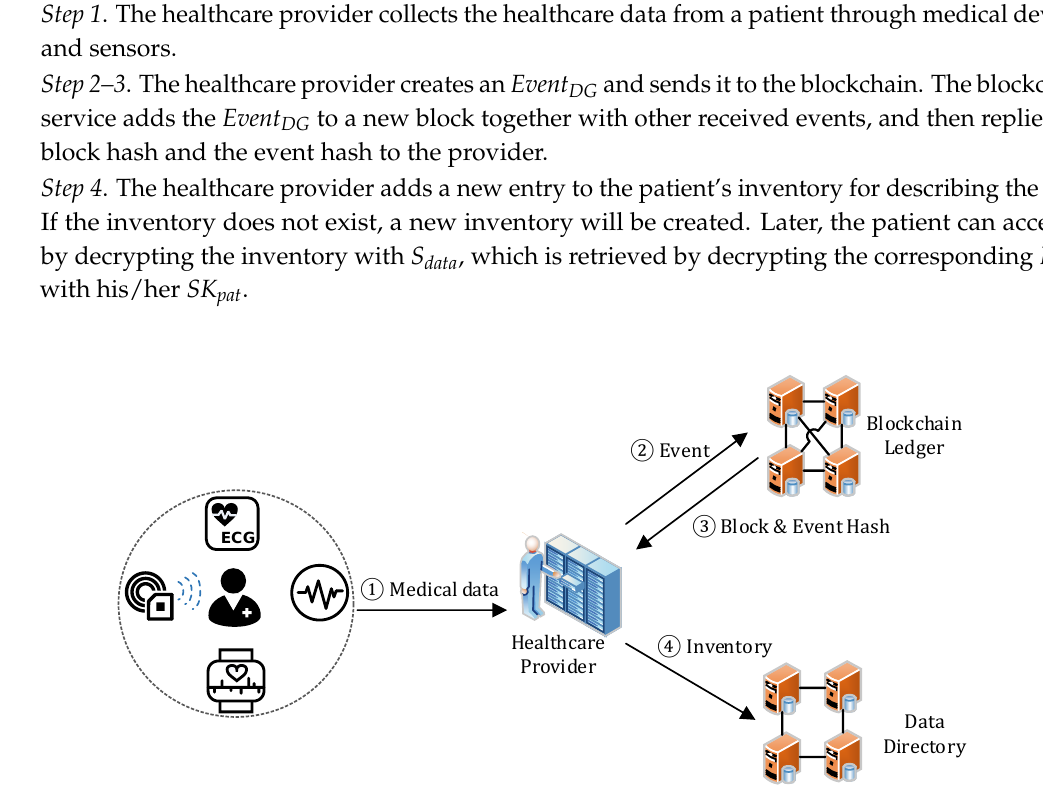
Figure 5. Process of new healthcare data generation.